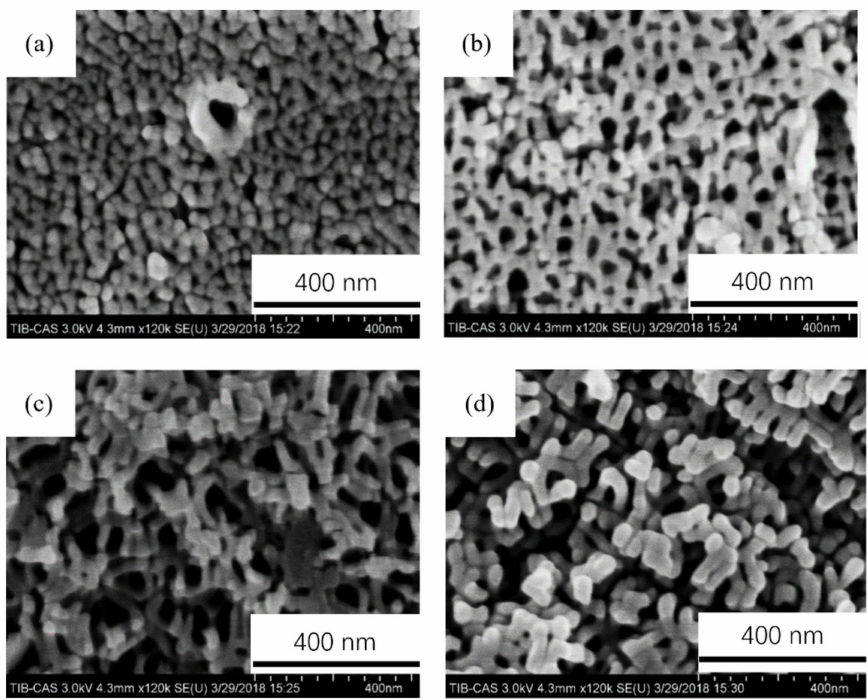
Figure 3. SEM images of 2024 anodic oxide films at different anodic oxidation times: ( a ) 10 min; ( b ) 20 min; ( c ) 30 min; ( d ) 100